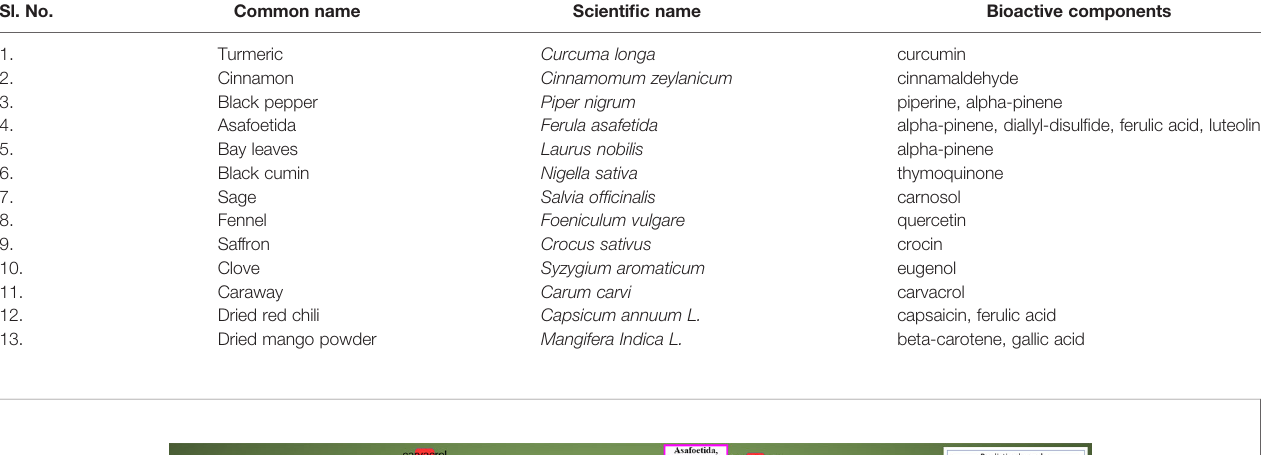
TABLE 1 | Common and scienti fi c names as well the bioactive components of selected spices. Sl. No.